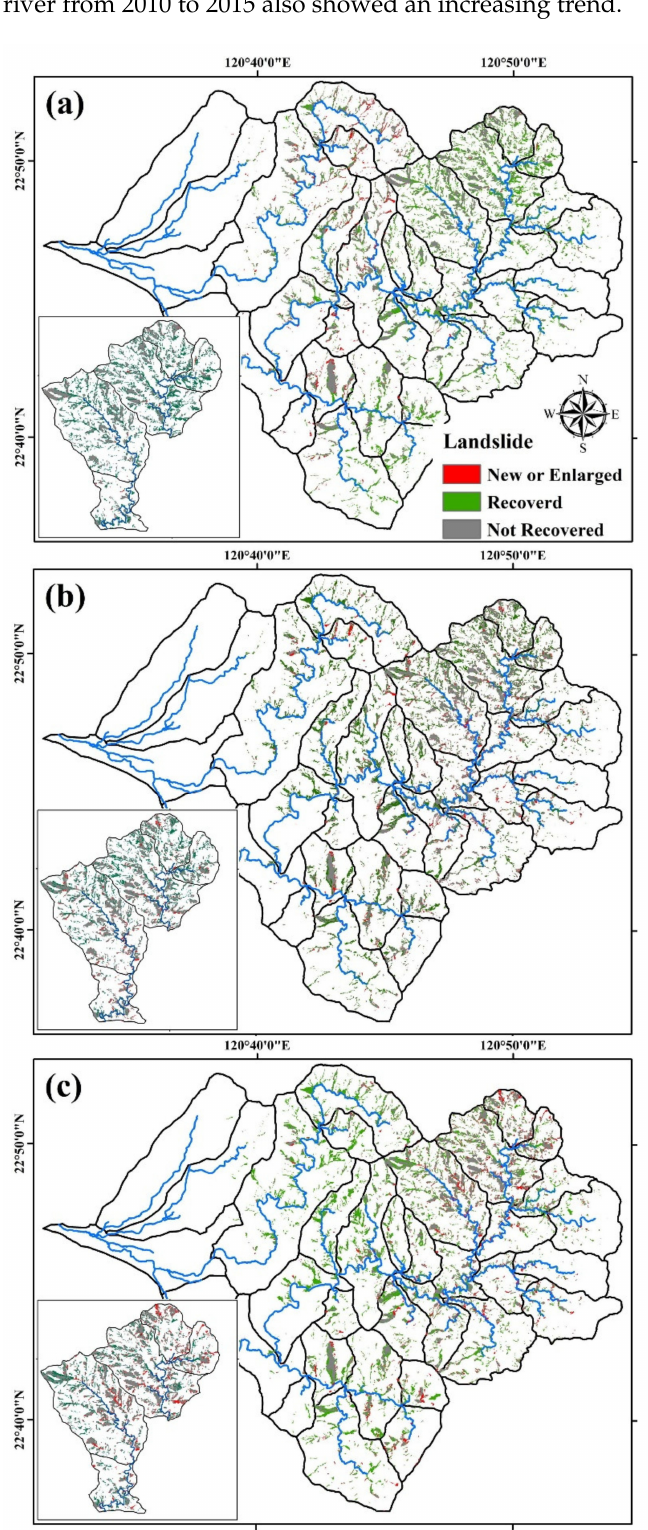
Figure 13. The landslide evolution from 2009 to 2010 ( a ), to 2013 ( b ), and to 2015 ( c ) in the ARW. The left down plot in each figure is the landslide evolution in the northeast ARW , including the A01, A02, A03, A07, and A11